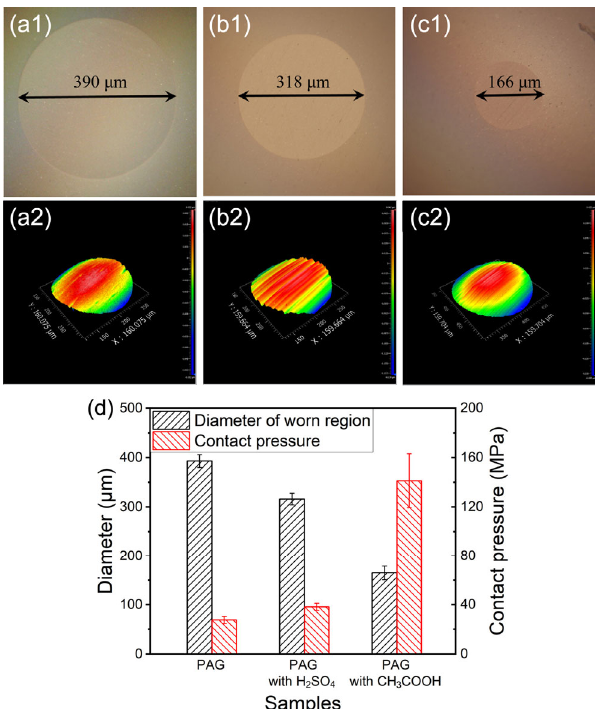
Fig. 2 Optical images (a1, b1, c1) and 3D morphology (a2, b2, c2) of the worn region on ball lubricated by (a1, a2) the PAG aqueous solution, (b1, b2) PAG aqueous solution with sulfuric acid, and (c1, c2) PAG aqueous solution with acetic acid. (d) Diameter of worn regions and the corresponding contact